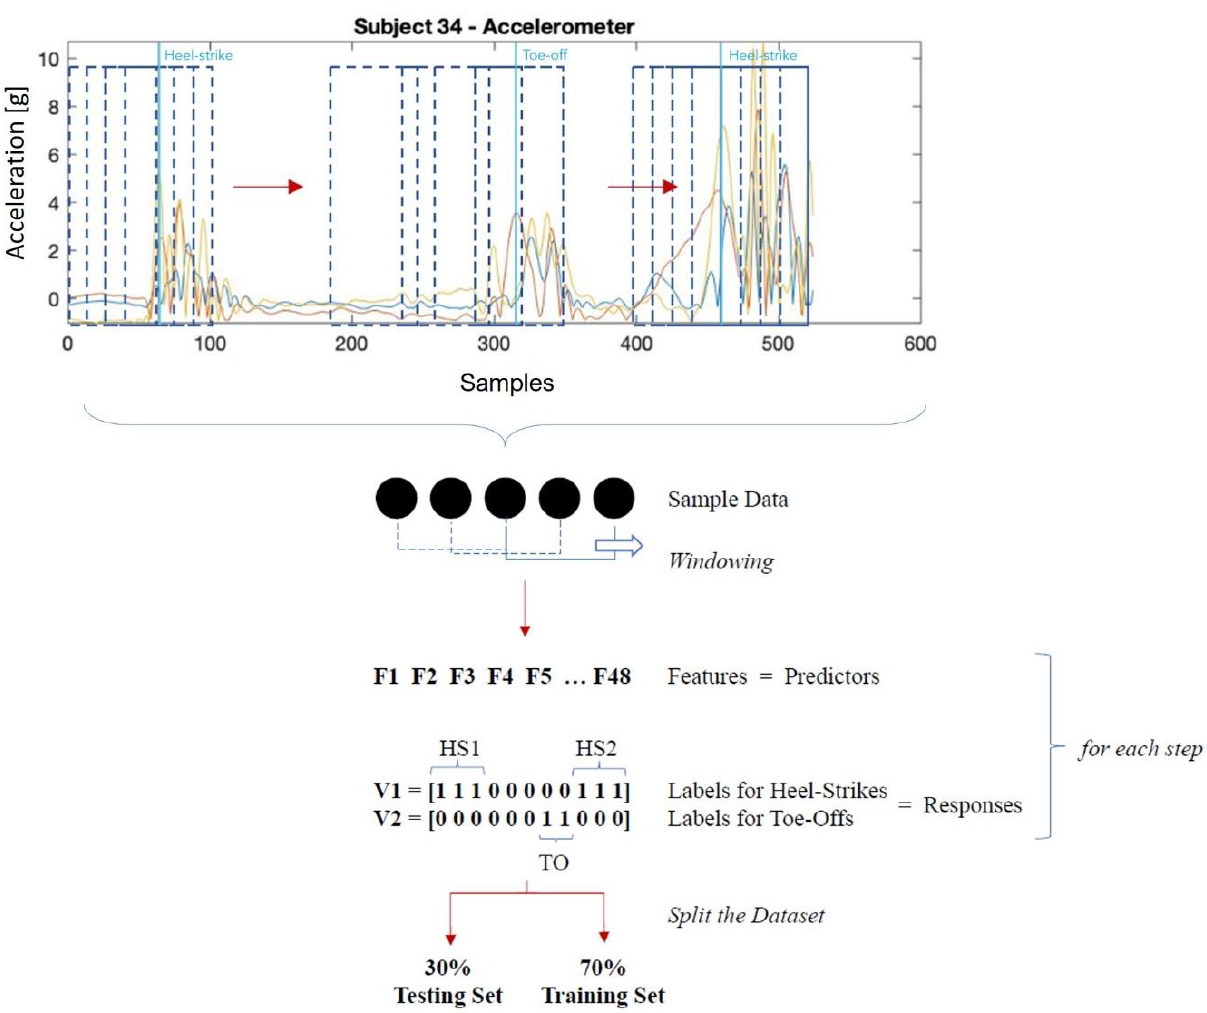
Figure 4. Data processing flow: sensors’ readings (in the top panel, sample acceleration signal) were windowed (dashed blue boxes represent the window moving across the signal); subsequently a set of features were obtained for each window, which was labelled according to the reference ground reaction force output. The whole set of collected strides (each one containing a collection of features) were randomly split into a training and a test set. HS: heel-strike, TO: toe-off.